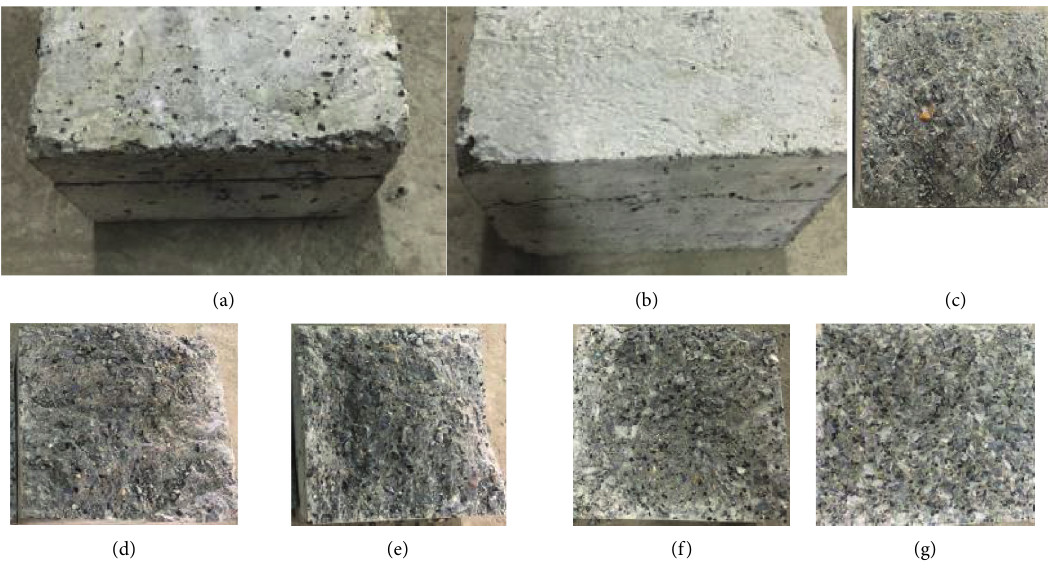
Figure 7: Pure shear failure modes of rubber concrete with different substitution rates. (a) Crack perpendicular to shear direction and (b) cracks parallel to the shear direction. (c) 0%, (d) 10%, (e) 20%, (f) 30%, and (g) 40%.